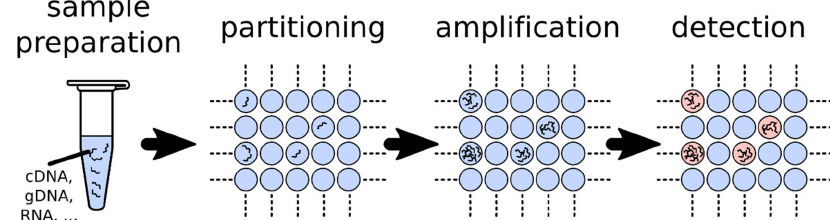
Figure 3. Principles of digital PCR. The sample is divided into many independent partitions such that each contains either a few or no target sequences. The distribution of target sequences in the partitions can be approximated with a Poisson’s distribution. Each partition acts as an individual PCR microreactor and partitions containing amplified target sequences are detected by fluorescence. The ratio of positive partitions (presence of fluorescence) over the total number allows to determine the concentration of the target in the sample.